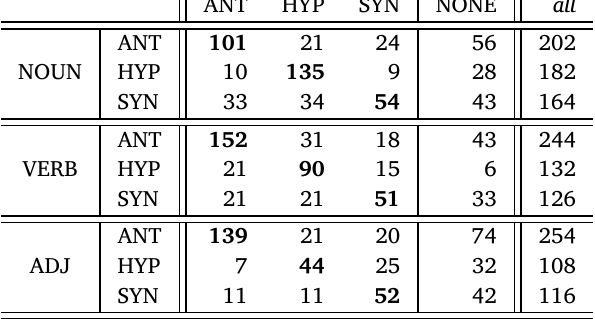
Confusion matrix for